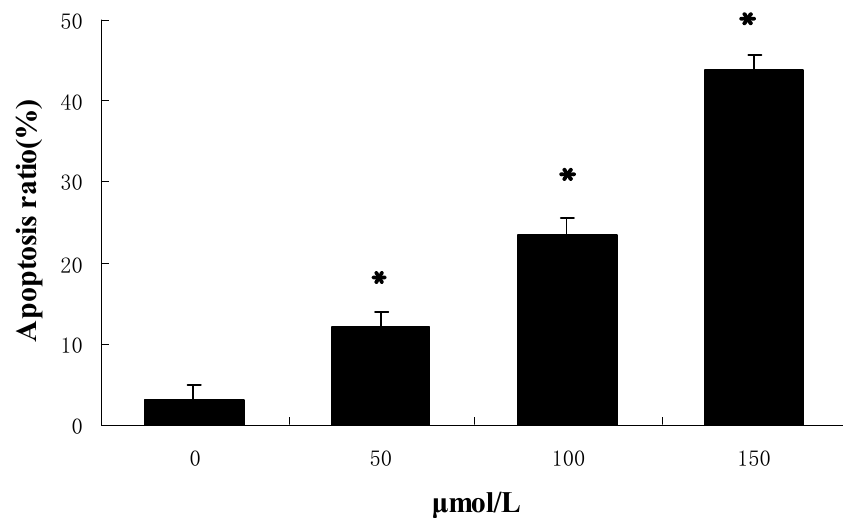
Figure 4. Results of the flow cytometry analysis.